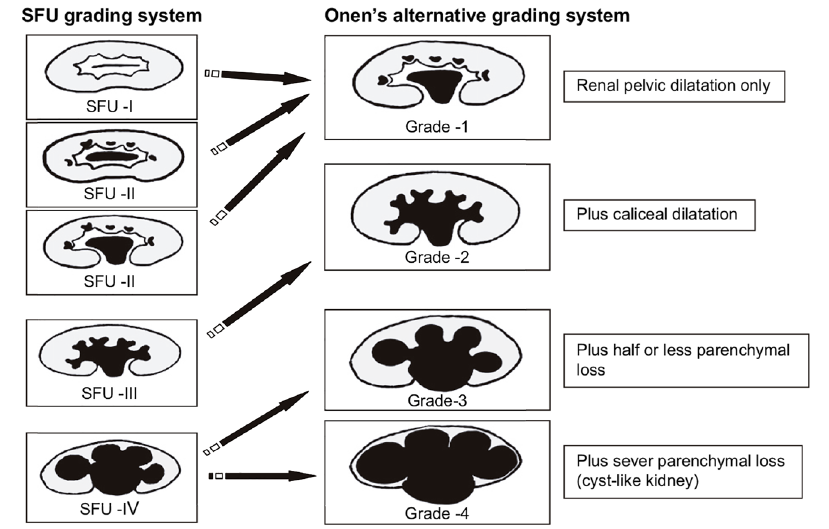
Figure 1. Comparison of SFU hydronephrosis grading system and Onen’s